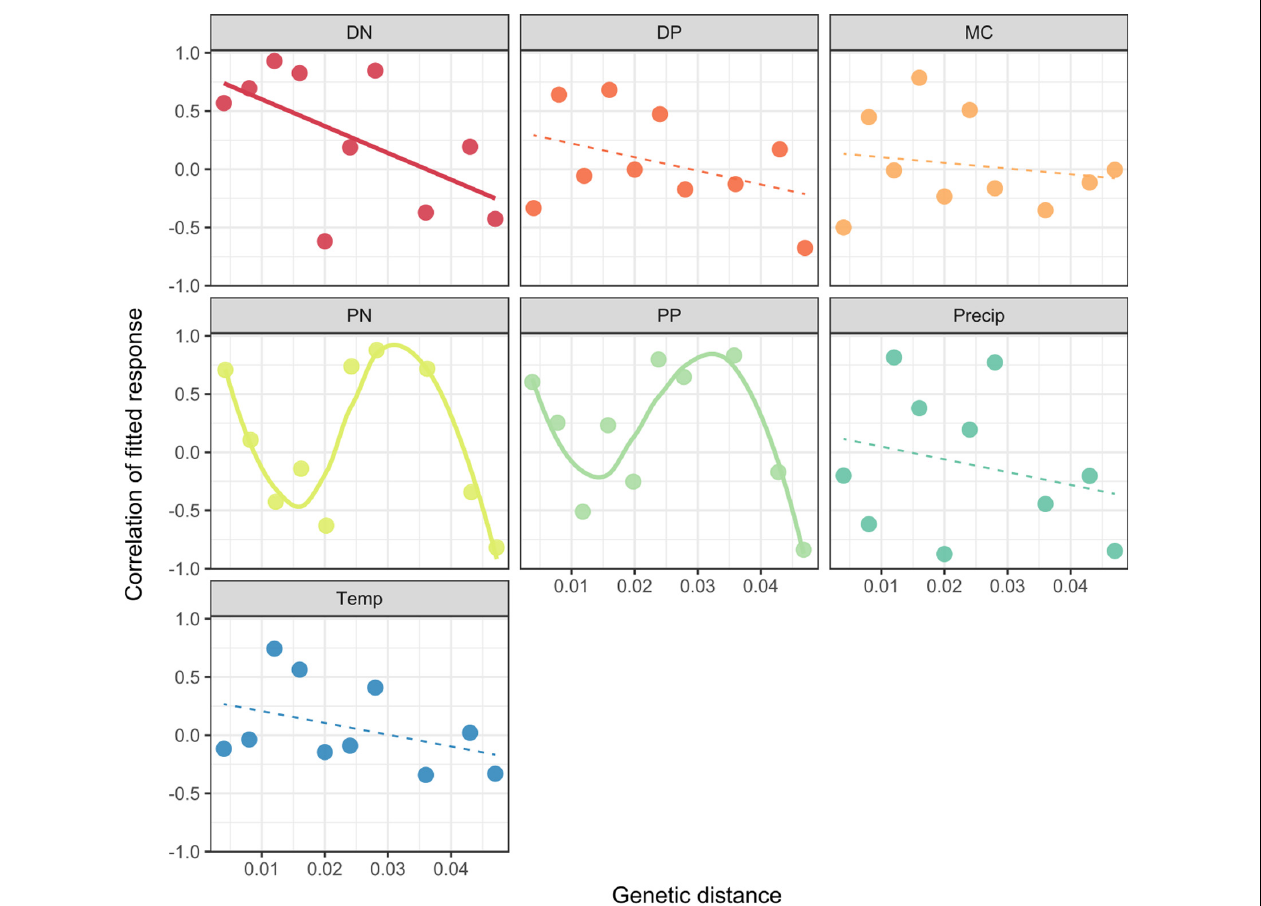
FIGURE 4 | The relationship between genetic distance and the co-response (niche similarity) for Dolichospermum . LVMs were used to identify correlations between the responses of MED nodes to each measured environmental parameter (separate panels). Positive correlations of fitted responses indicate similar niches; negative correlations indicate different niche preferences. Genetic distances were computed using the p-distance. Separate model fits were tested with the Akaike Information Criterion (AIC) for the relationship between each niche dimension and genetic distance. See Supplementary Table S4 for details of model fits. Significant model fits are shown with thick solid lines; non-significant fits are shown with dashed